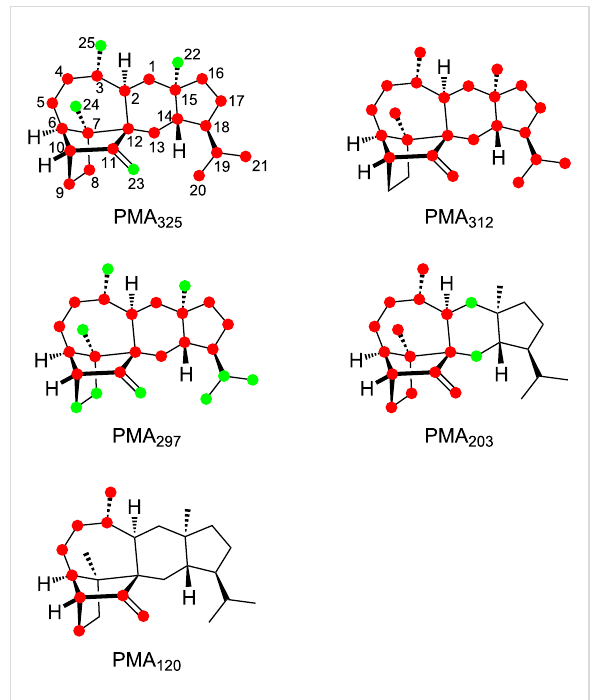
Figure 3: Position-specific mass shift analyses for 2 . The carbons that contribute fully to the formation of a fragment ion are indicated by red dots, partially contributing carbons are marked by green dots, and unlabelled carbons do not contribute and are thus cleaved off by the fragmentation